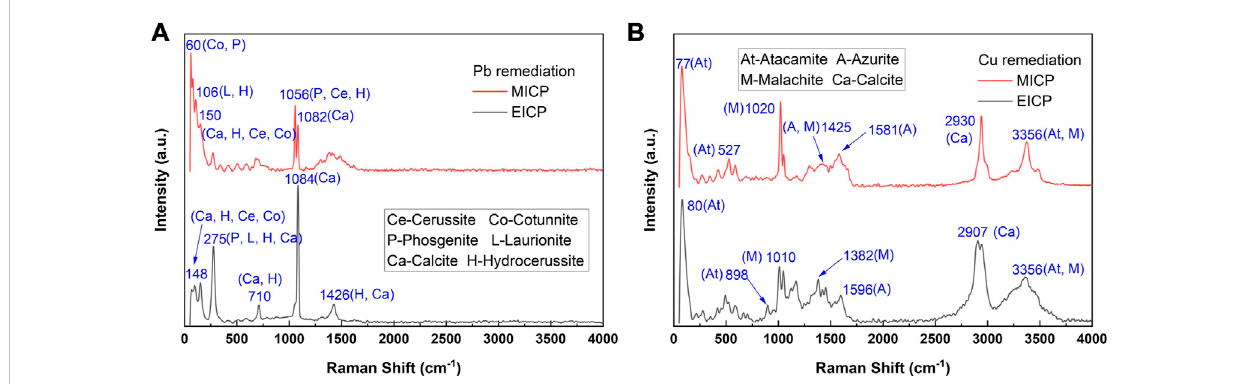
Raman spectra of samples taken under EICP and MICP: (A) Pb remediation and (B) Cu remediation.